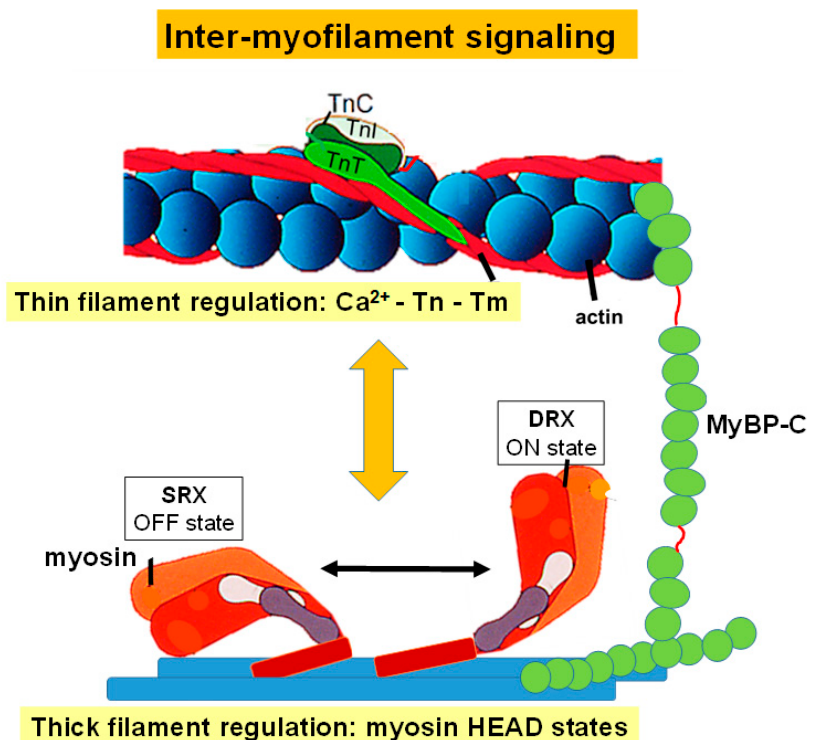
Figure 2. Inter-myofilament Signaling in the Cardiac Sarcomere. This figure depicts regulation of thin filament activation, which is driven through calcium binding to troponin C (TnC), TnC and troponin I (TnI) interactions, and the position of tropomyosin (Tm). It also illustrates activation of the thick filament regulated through myosin head states. Myosin-binding protein C has also been included due to its role in regulating interactions between the thin and thick